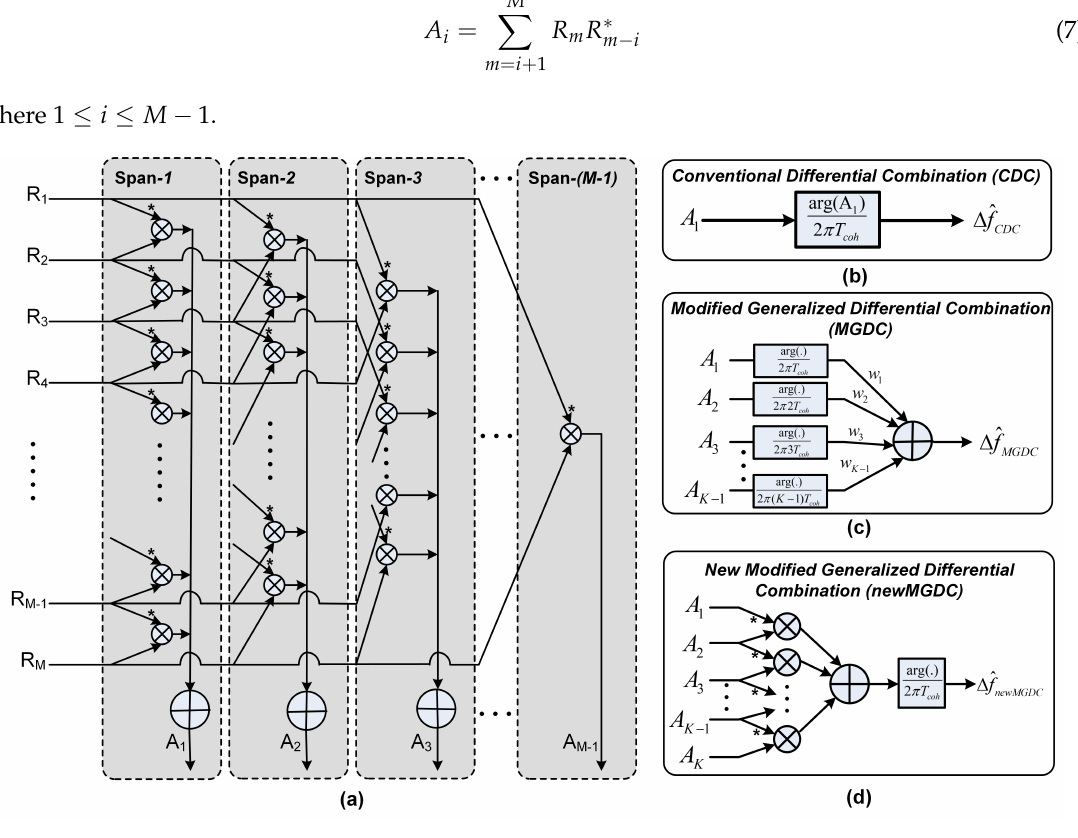
Figure 2. Differential processing for frequency estimating. ( a ) differential operations; ( b ) conventional differential combination; ( c ) modified generalized differential combination; ( d ) modified generalized differential